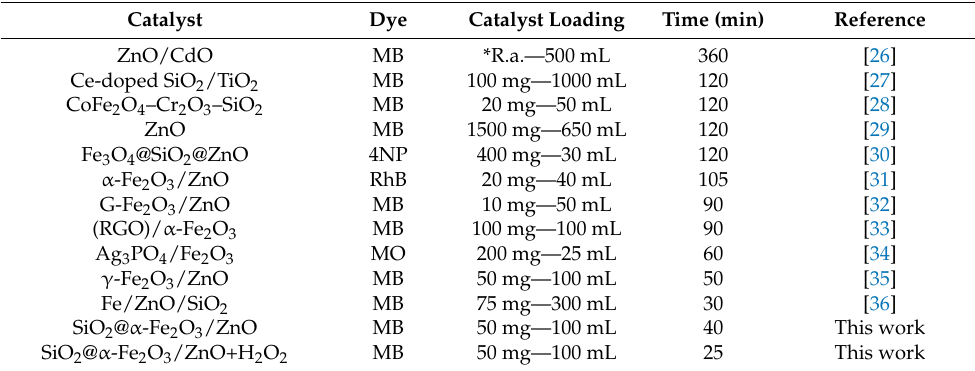
Table 3. Comparison of our work with the reported work.